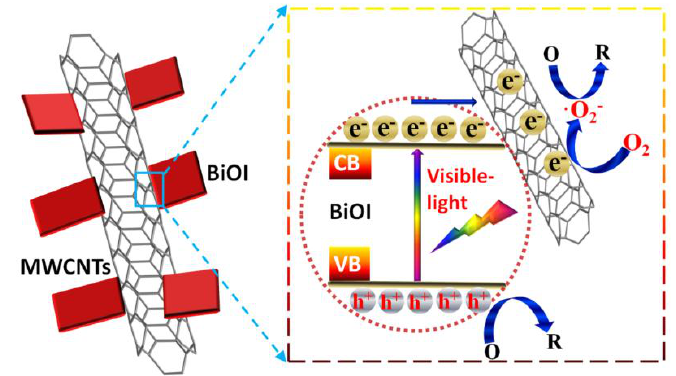
Figure 11. The proposed photocatalytic mechanism for the high activity of MWCNTs/BiOI.